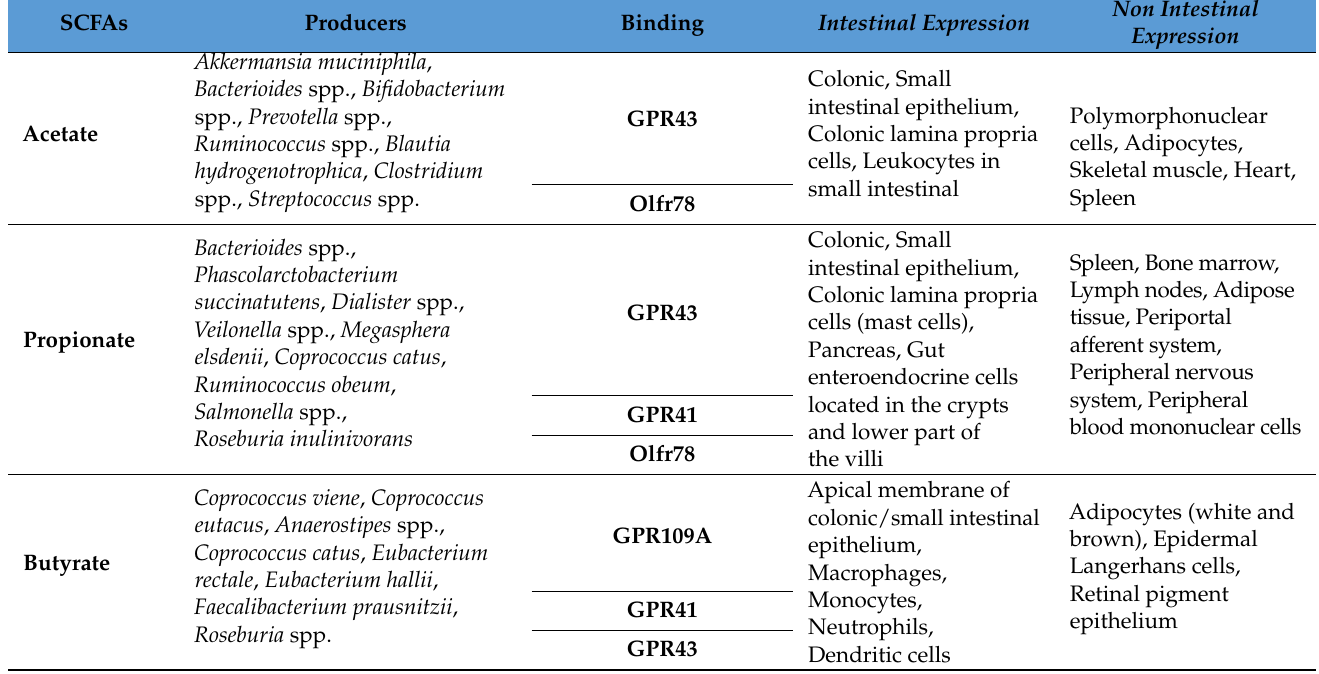
Table 1. Acetate, propionate, and butyrate are formed in the human colon in an estimated ratio